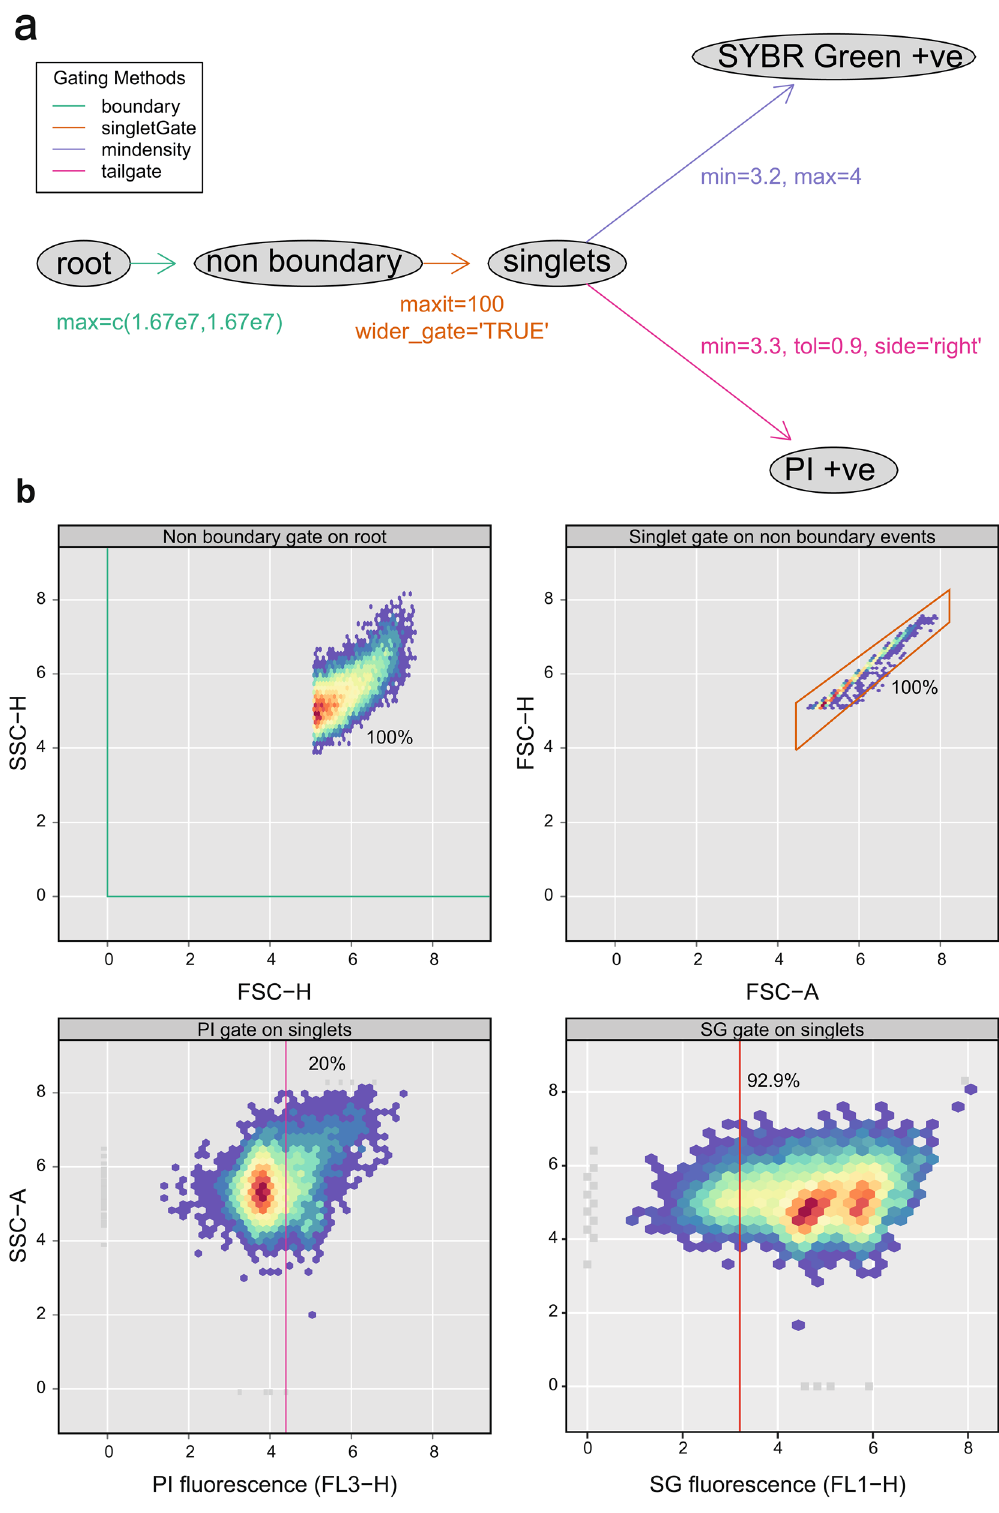
Figure 7. Gating strategy used for the study. a —Gating template showing the population nodes, gating methods and parameters used to calculate subpopulations. Where root is the starting population (all events), non-boundary population are those events which do not fall on the axes (the position of the boundary filter has been indicated as a green line in the plot). Singlets are those events within the singlet gate, SYBR Green + ve and PI + ve are those events which were positively gated in FL1-H and FL3-H, respectively. The min and max parameters for the SG gate are set to avoid erroneously gating between low and high nucleic acid content microbes. b —Example plots (based on a randomly selected PI-stained sample for the FL3-H plot and an SG-stained sample for the FL1-H plot) showing the gates used at each step (color-coded as in a ). Autofluorescent events were observed for ~ 1–5% of the populations in the FL1-H and FL3-H channels (as shown in Supplementary Fig.